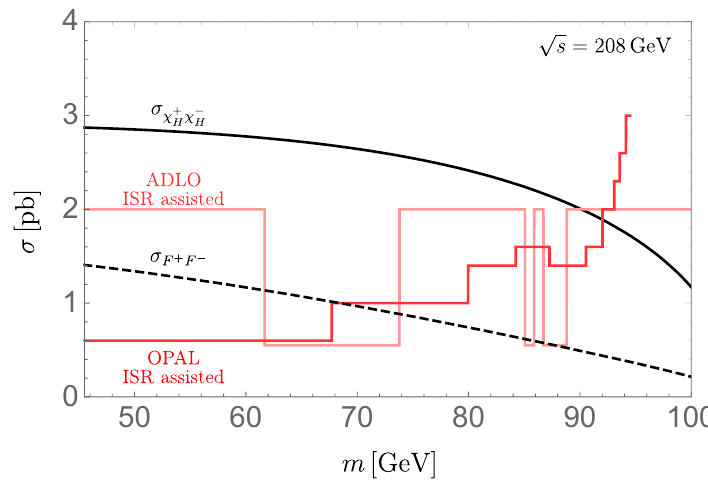
Figure 1 . LEP higgsino pair production cross section, (cid:27) (black solid), and charged fermion (cid:31) + H (cid:31) (cid:0) H pair production cross section, (cid:27) , allowing for t -channel interference (black dashed). In the F + F (cid:0) t -channel diagram shown in (cid:12)gure 2, the coupling is set to (cid:20) = 0 : 5 and the singlet mass to m S = 110 GeV. The light and dark red lines are the LEP limits on the pair production cross section from [56] and [57], respectively. The limits in this (cid:12)gure assume higgsino-like decays, and a charged- neutral mass splitting of (cid:1) m = 2 : 7 GeV.